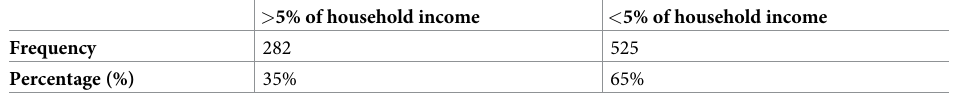
Table 7. Expenditure to income approach for ability to